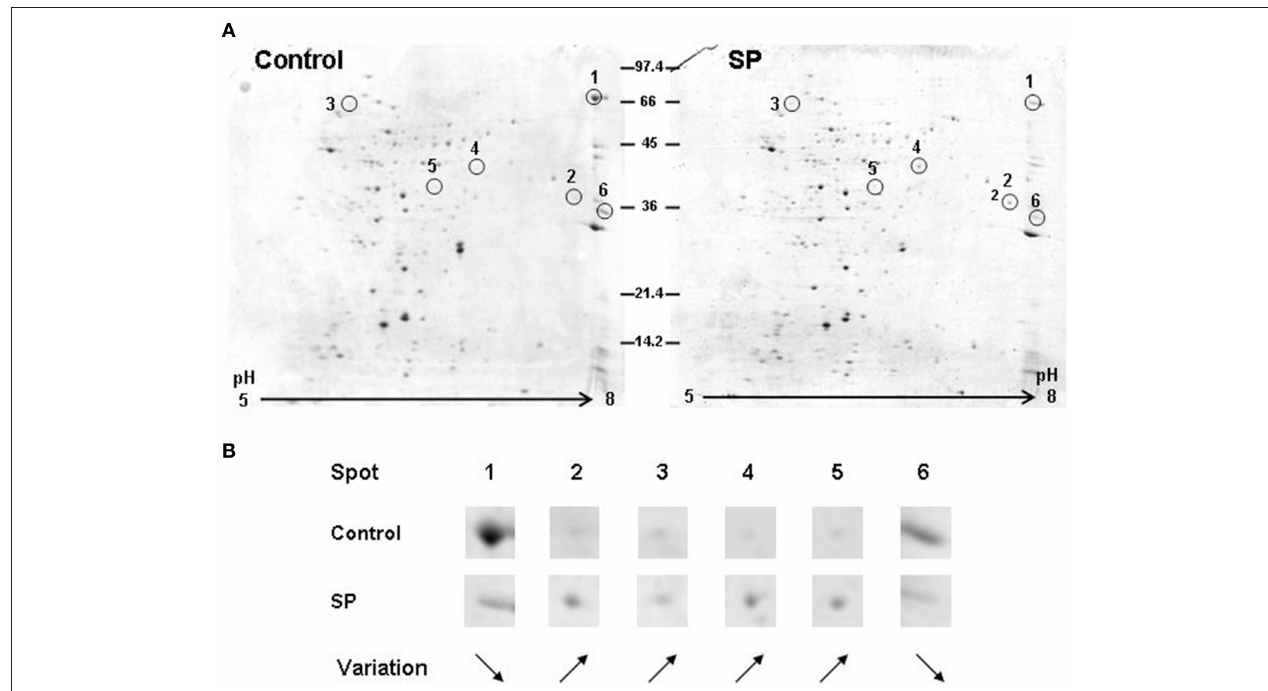
FIGURE 6 | Bidimensional electrophoresis analysis of secreted S. aureus MFP03 proteins after 1 h treatment with Substance P reverse (Control) or Substance P (SP) (10 − 6 M). (A) Six spots were modified after exposure of the bacteria to SP. (B) Two proteins (1 and 6) were markedly decreased whereas the expression of four others was upregulated. Proteins corresponding to these spots are presented in Table 2 . Results are representative of three independent experiments.